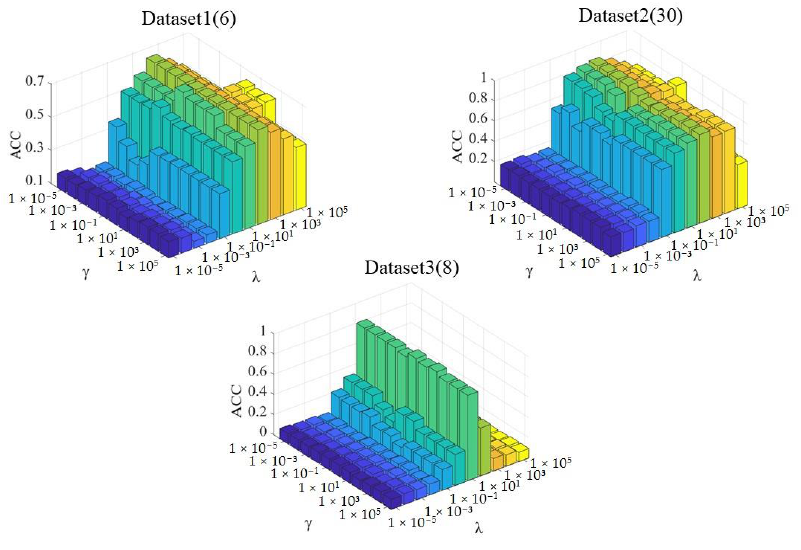
Figure 7. The ACCs of OBDR with different λ and γ .